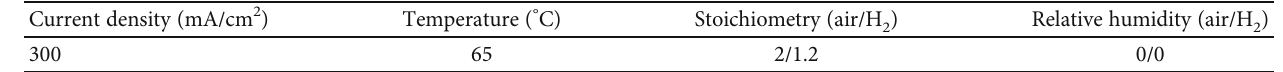
Table 1: The experimental operating